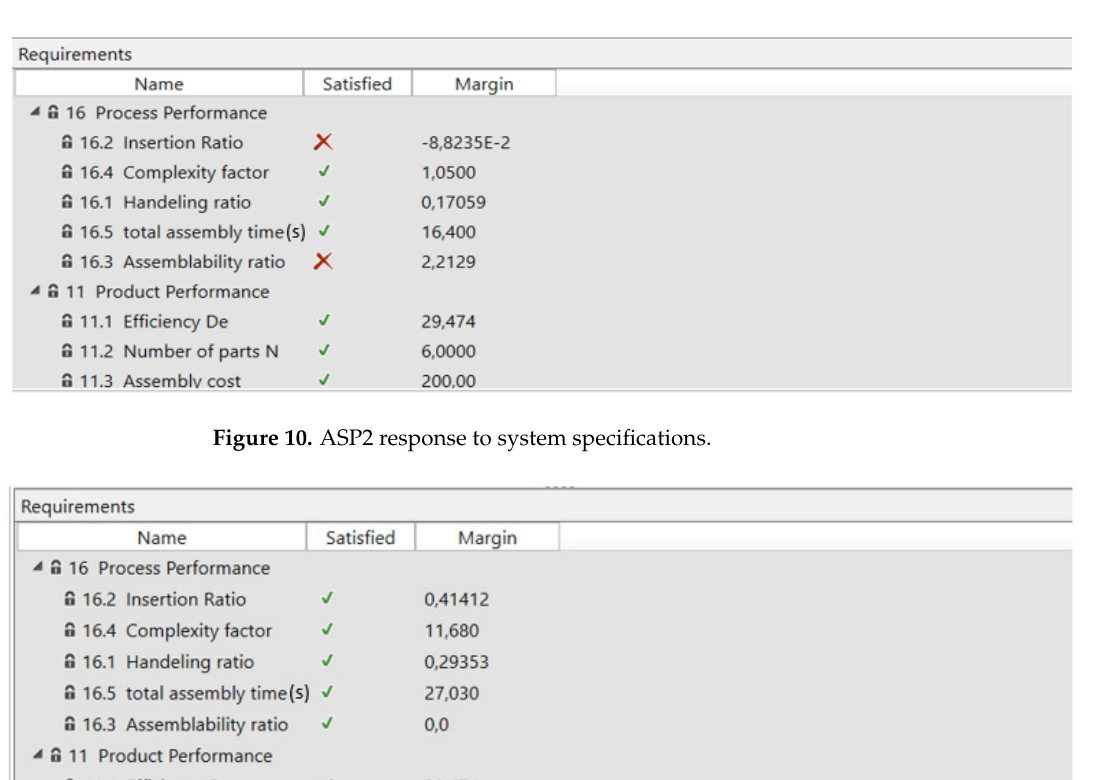
Figure 9. ASP1 response to system specifications.